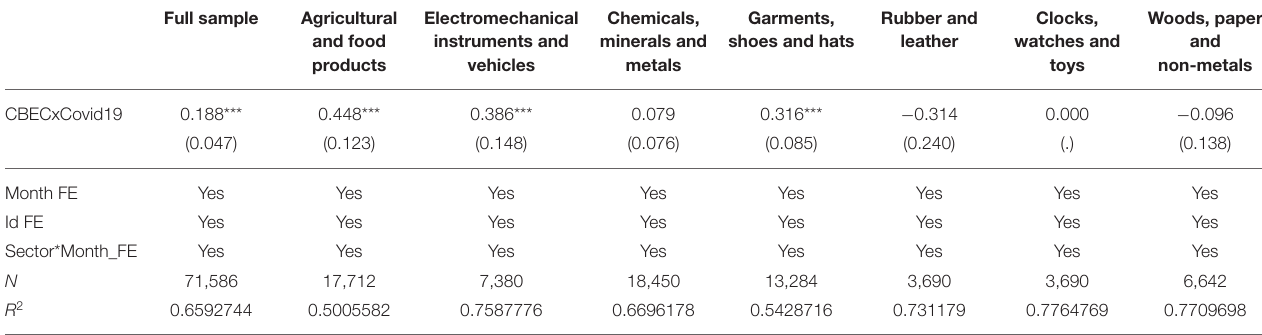
TABLE 8 | Regression results of the sector heterogeneity